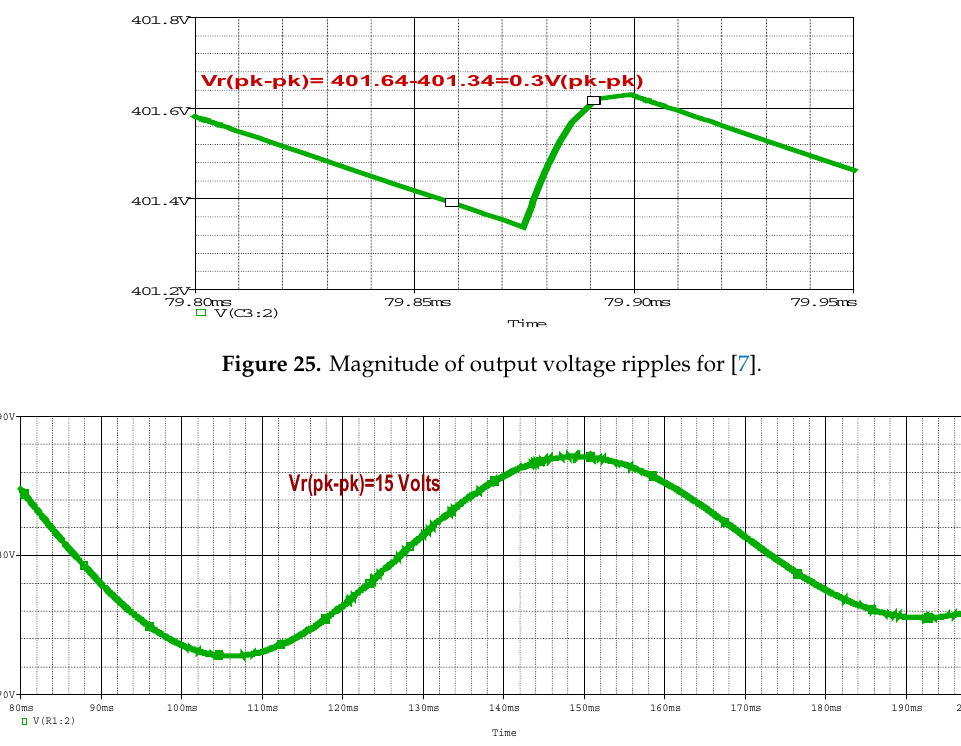
Figure 26. Magnitude of output voltage ripples for conventional boost converter [28].